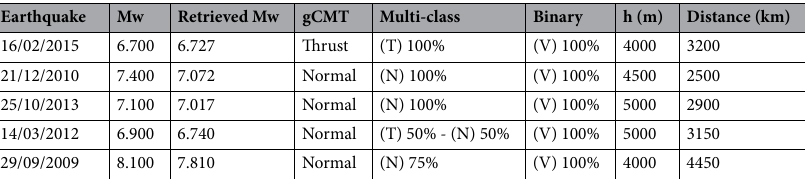
Table 5. Results delivered by the ML algorithms. Distance refers to the hydrophone-epicentre separation, (V) stands for vertical earthquake, (H) for horizontal, (N) for normal and (T) for thrust. gCMT are the reported slip types. h is the average ocean depth between the epicentre and hydrophone.